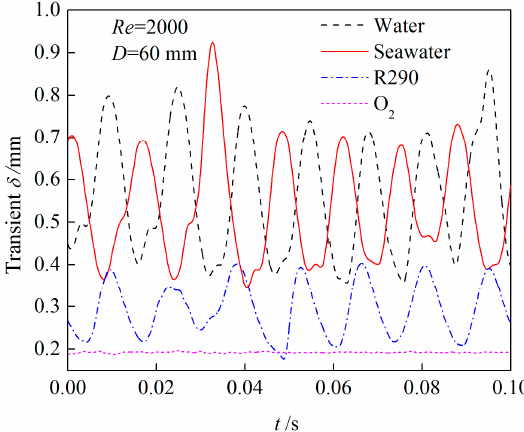
Figure 14. Transient film thickness on the horizontal tube.